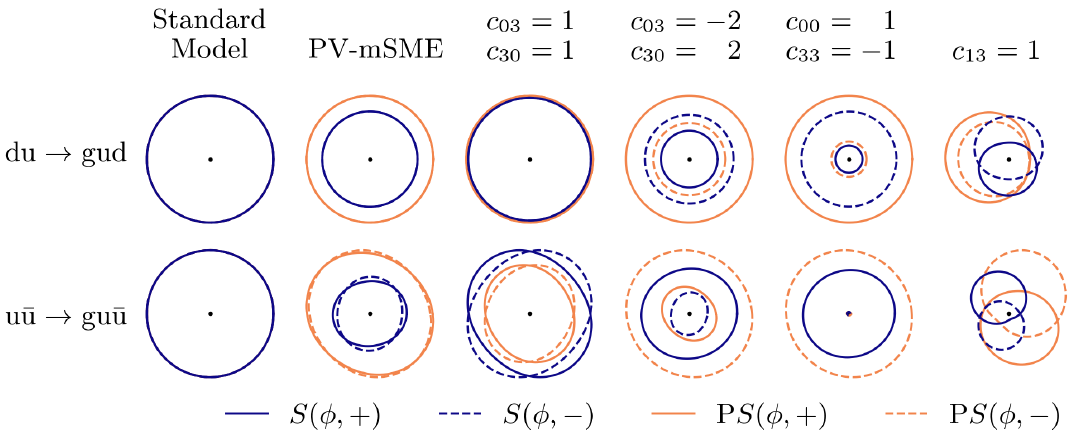
Figure 11 . Helicity-summed, magnitude-squared matrix elements |M| 2 displayed as radial distances, such that differences between the orange and blue lines indicate parity violation. Momenta are rotated by S ( φ, ± ) , where φ is the angle from the vertical axis. Parton distribution functions are invariant under these rotations, so |M| 2 is proportional to the differential cross-section. The Standard Model is invariant under rotation and parity operations. The PV-mSME has ( c ) A µν couplings from equation (3.3); latter columns modify the ( c ) coupling matrix by their stated A µν assignments. Top: ~p = (200 , 400 , − 600) , ~p = ( − 200 , − 150 , 200) , and ~p = (0 , − 250 , 1200) GeV . g u d Bottom: ~p = (100 , 250 , 250) , ~p = (200 , 250 , 400) , and ~p = ( − 300 , − 500 , − 300) GeV g u ¯u